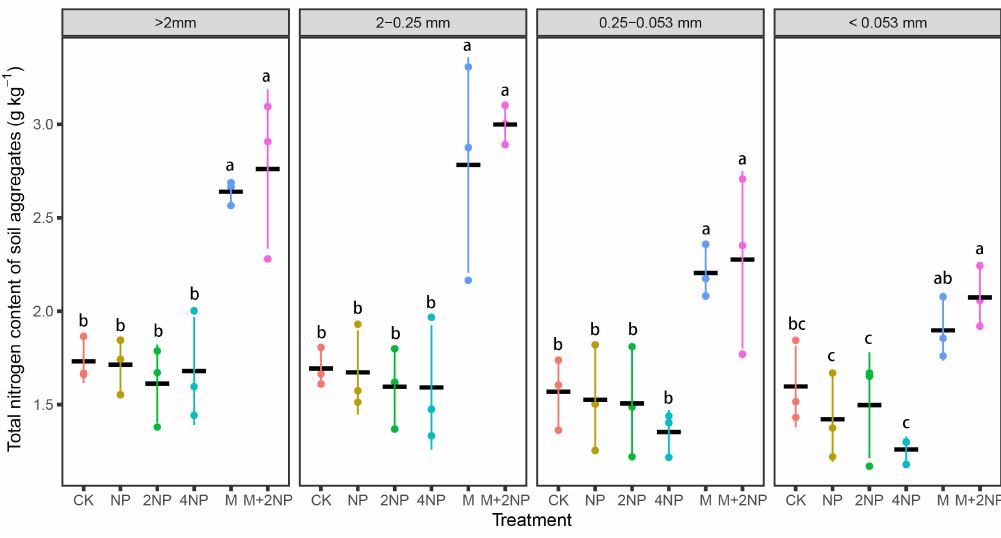
Figure 5. Total nitrogen content of soil aggregates. The black horizontal and colorful vertical lines represent the mean and SD, respectively, and the dots next to them represent the respective measured values. Different lowercase letters show significant differences among fertilization treatments in the same aggregate fractions ( p < 0.05). Values are given as means ± SD (n = 3). Abbreviations: CK = no fertilizer; NP = low−dose chemical fertilizer; 2NP = moderate−dose chemical fertilizer; 4NP = high−dose chemical fertilizer; M = normal−dose organic fertilizer; M+2NP = normal−dose organic fertilizer + moderate−dose chemical fertilizer.